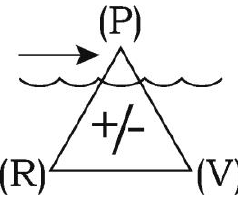
Figure 4a: The Submerged Compassion Triangle - only Persecutor apparent on Top